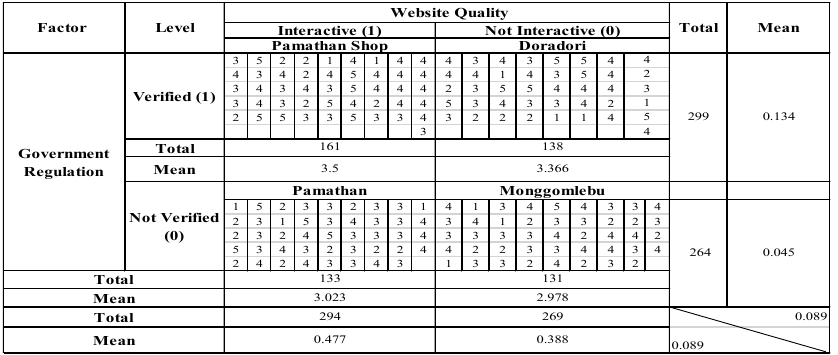
Source: data processed by researchers Fig. 3. Experimental Matrix of Factorial Randomized Design Based on the results of experiments that have been conducted, it was known that the highest mean was obtained in cell